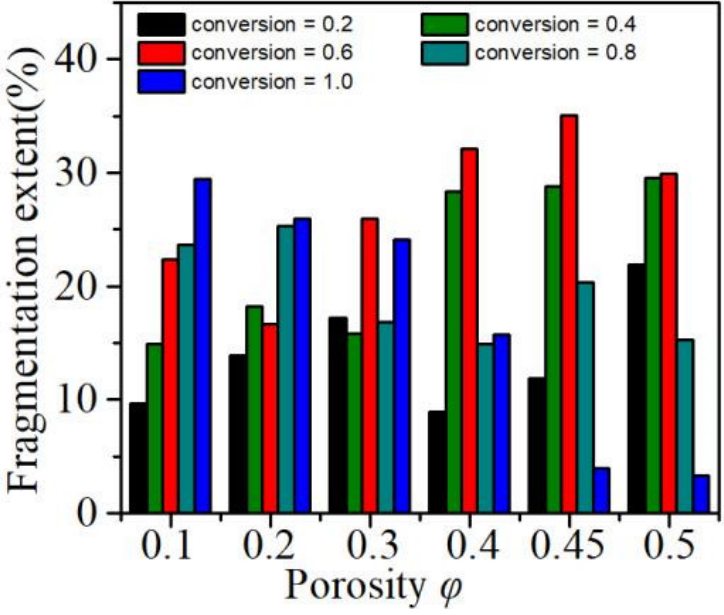
Figure 7. Change of char fragmentation with increasing char conversion.